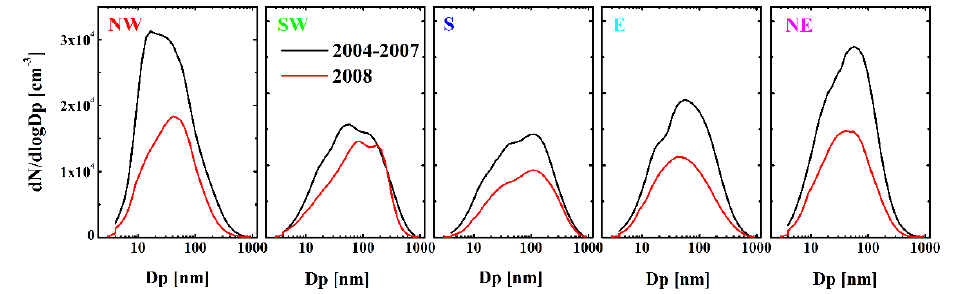
Figure 5: Mean particle number size distributions for five trajectory clusters, according to the classification in Fig. 3. Black line indicates the mean values from 2004 to 2007, and the red line represents the mean values of 2008. 770 Table 3. Comparisons of particle number and volume concentrations between different modes (mean ± standard